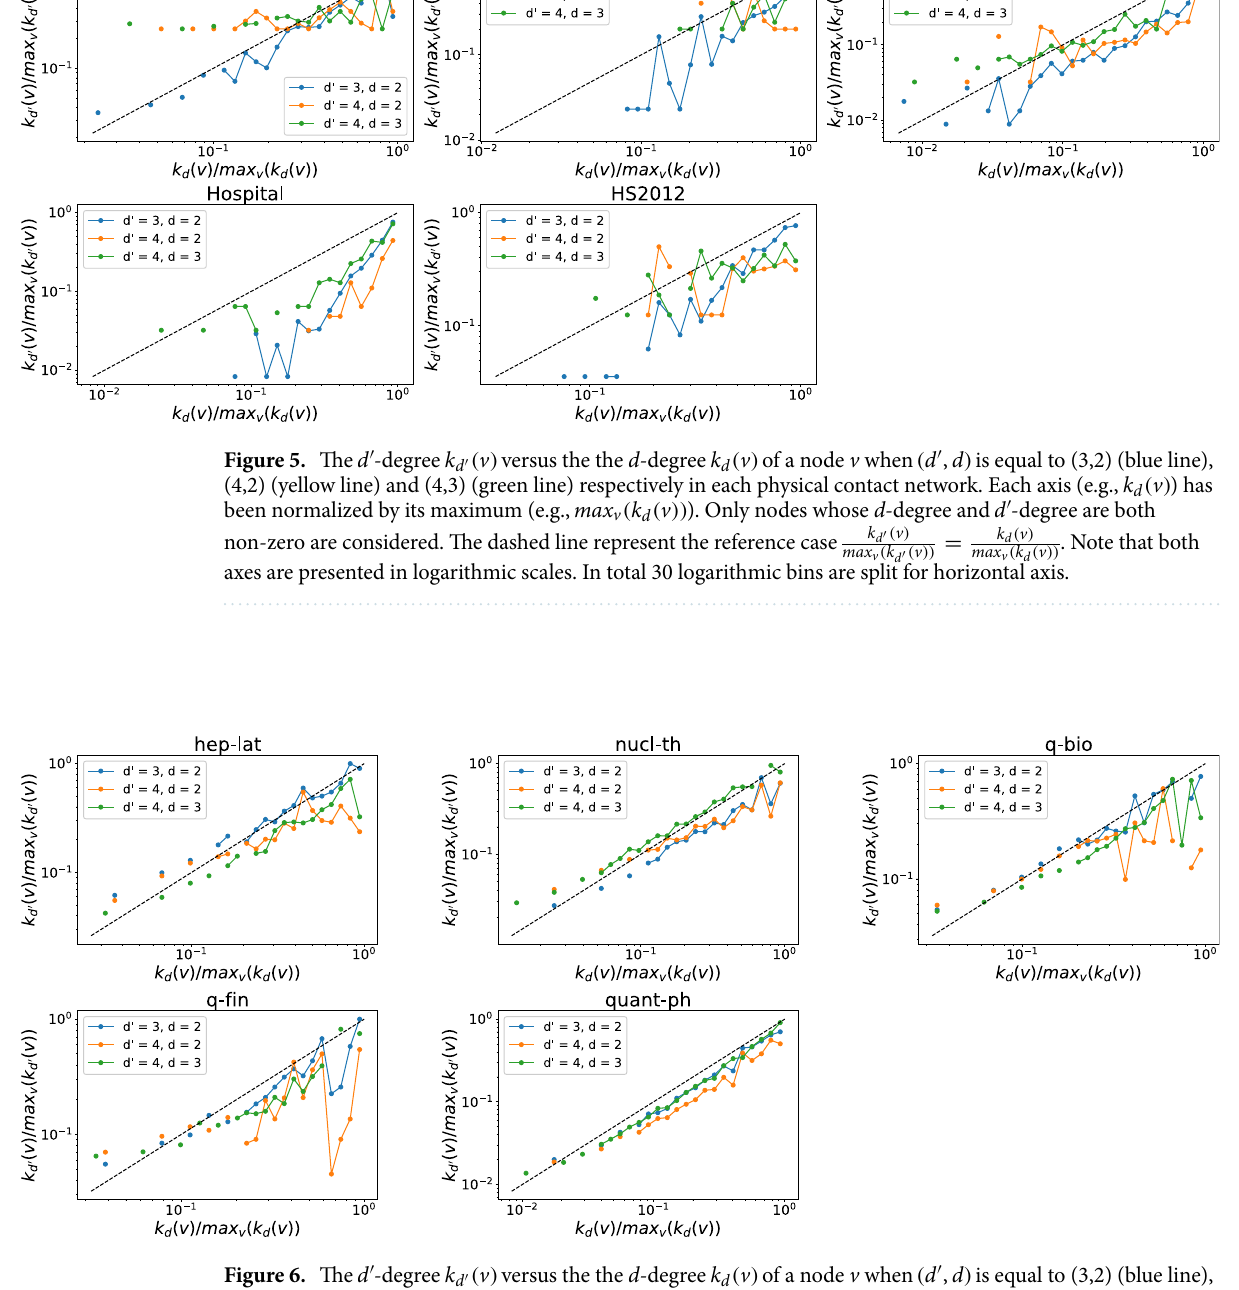
k d ′ ( v ) = k d ( v ) max v ( k d ′ ( v )) max v ( k d ( v )) . Note that both